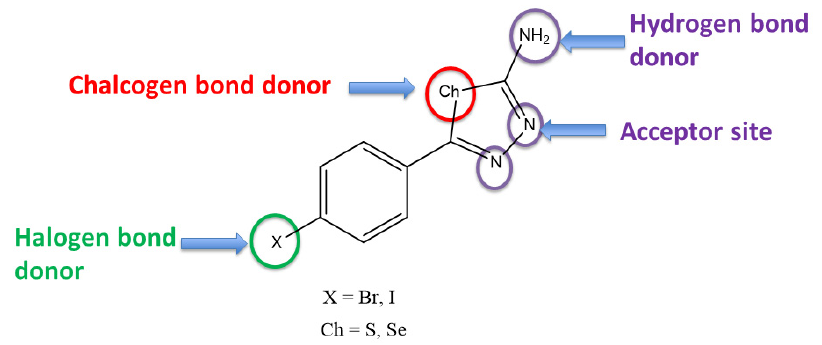
Figure 1. 1,3,4-Chalcogenadiazole derivative with multiple donor and acceptor sites.